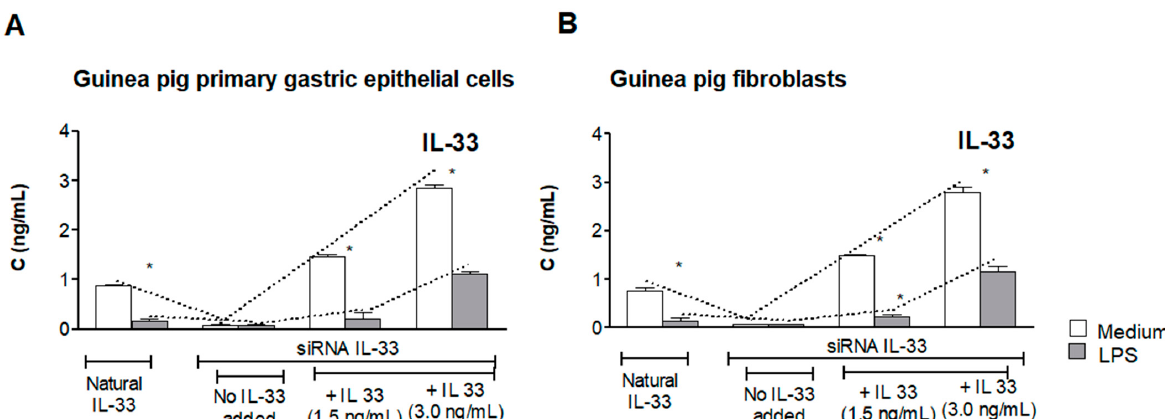
Figure 1. The concentration of IL-33 in cell culture supernatants. The level of IL-33 was assessed in cell cultures of guinea pig-derived primary gastric epithelial cells ( A ) or fibroblasts ( B ). Cells not transfected or transfected with siRNA IL-33 were used. Cells were sub-cultured with or without H. pylori lipopolysaccharide (LPS), 25 ng/mL, in the presence or ab- sence of exogenous IL-33 (1.5 or 3.0 ng/mL). The concentration of IL-33 was estimated after 24 h in cell culture superna- tants by the enzyme-linked immunosorbent assay (ELISA). Results are shown as median with the range of five experi- ments performed in triplicate for each experimental variant. Statistical analysis was performed using the nonparametric Mann-Whitney U test with significance at p < 0.05 * unstimulated vs. LPS H. pylori stimulated cells.